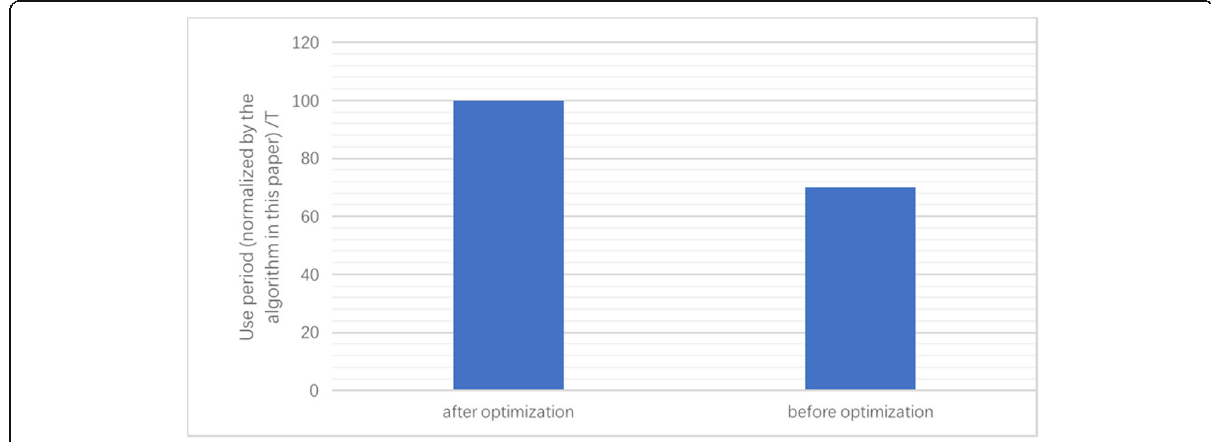
Fig. 9 Comparison and analysis of life cycle before and after